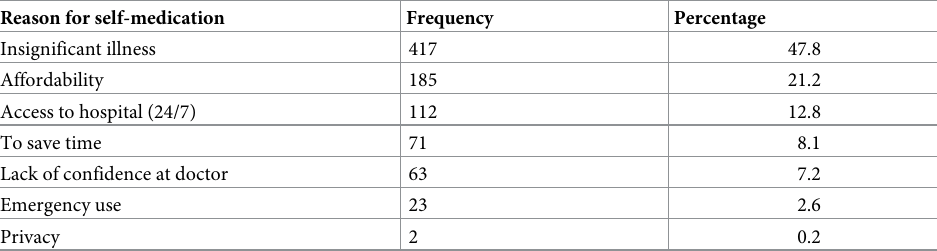
Table 3. Reason of self-medication (n =